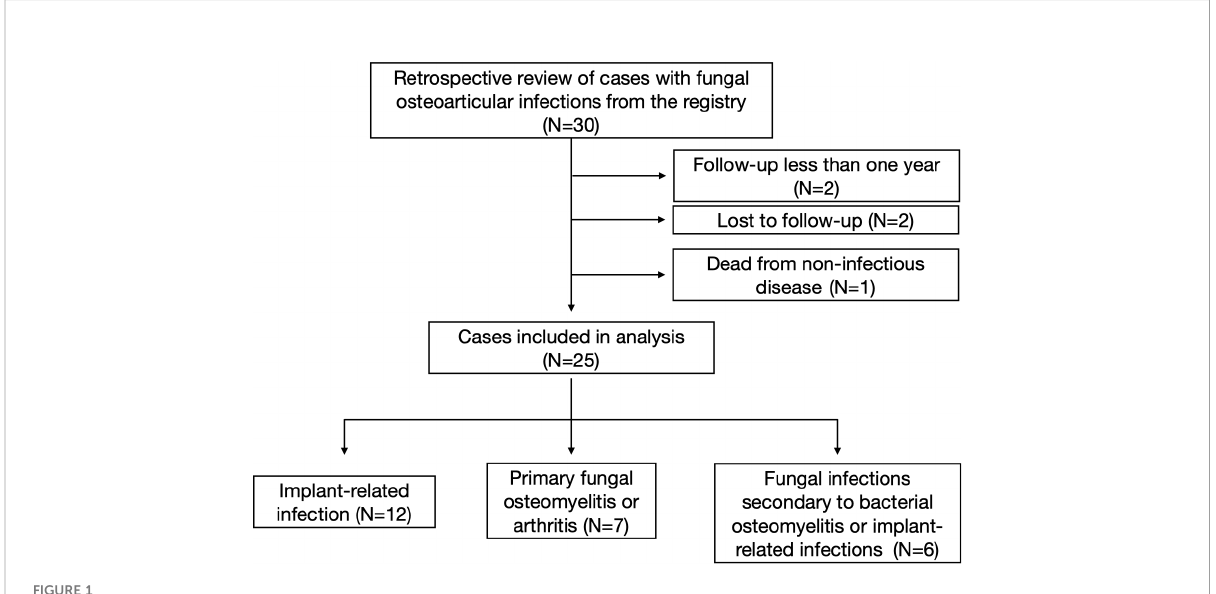
FIGURE 1 The fl ow diagram of enrollment of